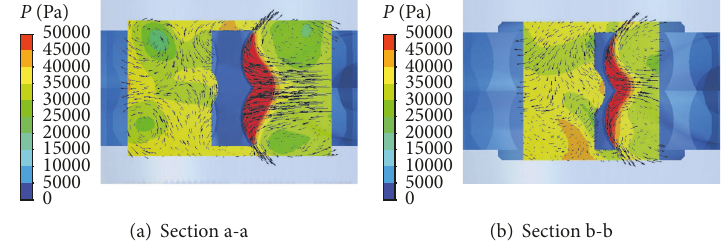
Figure 24: Static pressure distributions and absolute velocity vectors of Blade B ( 𝜃 ∗ = 36 ∘ , 𝑛 = 150 ,000 min −1 ).